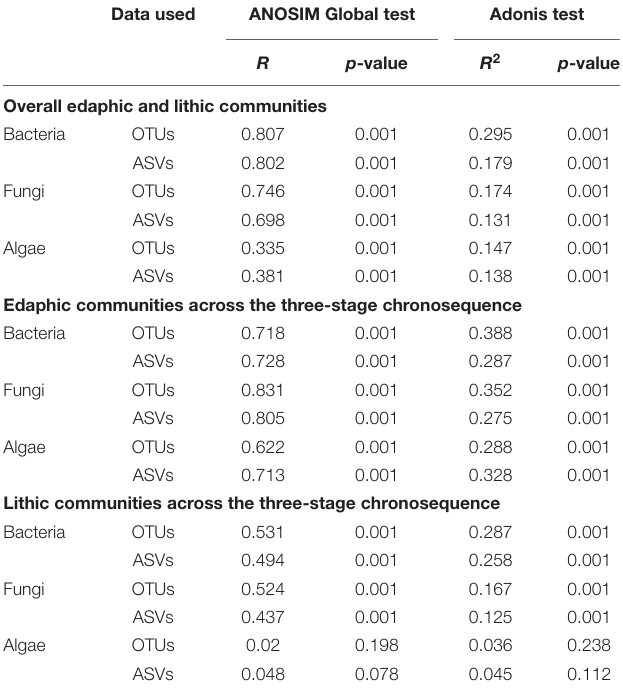
TABLE 2 | ANOSIM and Adonis tests results based on OTU and ASV data. TABLE 3 | Compositional dissimilarities among bacterial, fungal and algal communities developing on rocks and